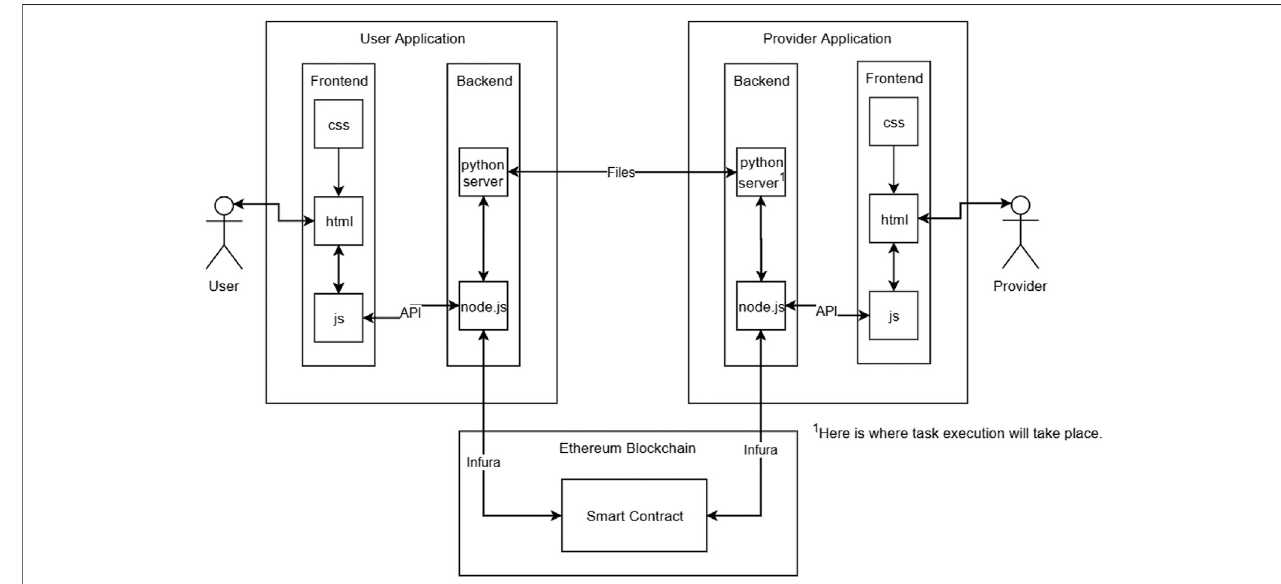
FIGURE 2 | Architectural overview.